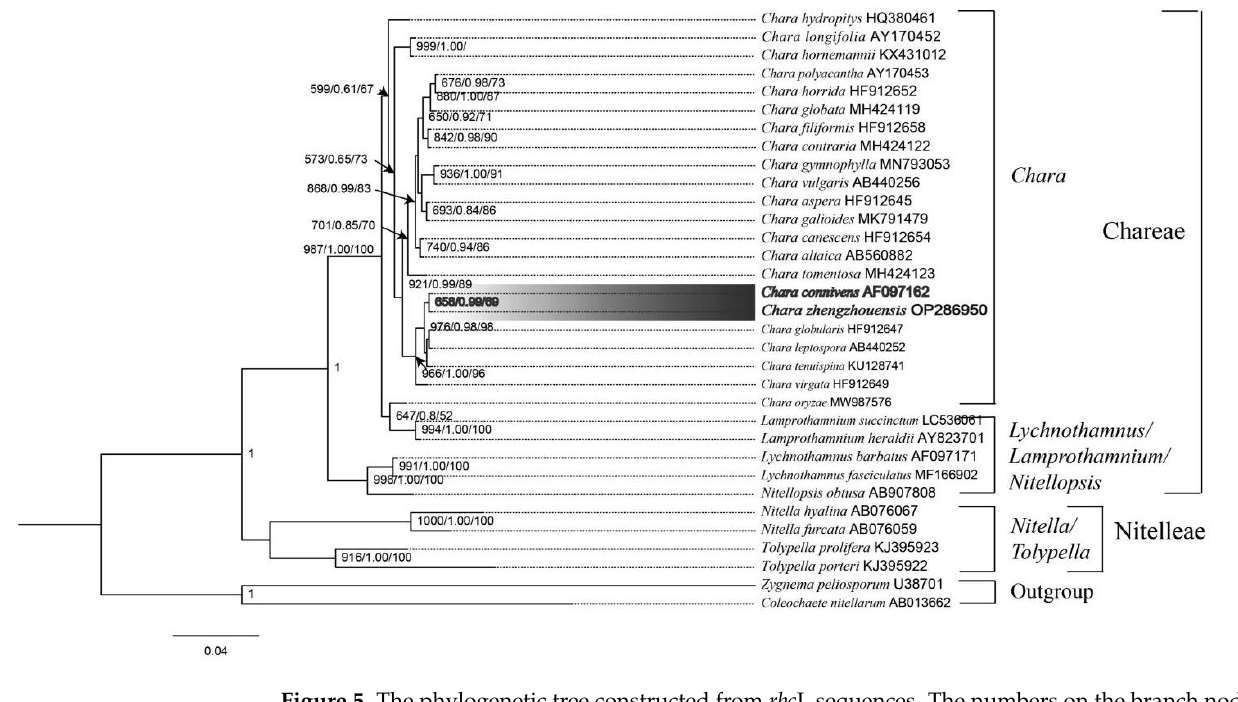
Figure 5. The phylogenetic tree constructed from rbc L sequences. The numbers on the branch nodes represent the maximum likelihood bootstrap tree support values, Bayesian posterior probabilities, and neighbor joining bootstrap tree support values. Supporting values below 50% were noted with “ - ”.